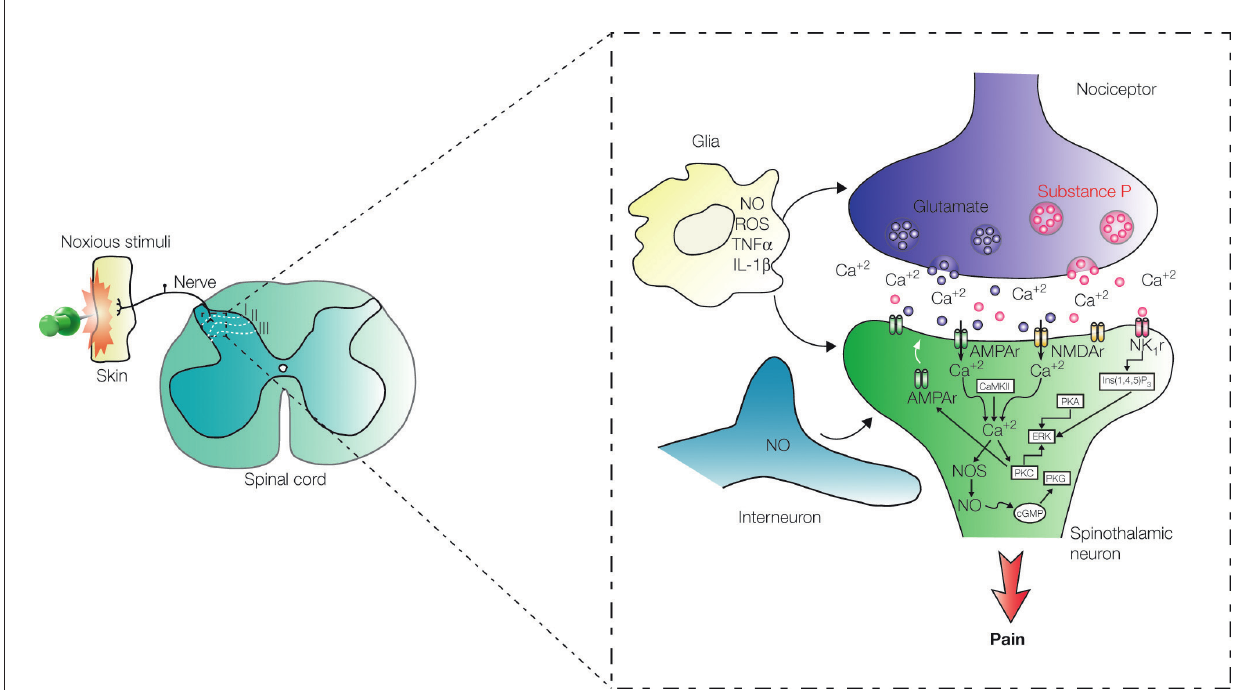
Figure 2 | Processing of pain information in the spinal cord. Pain signals are transmitted to the dorsal horn by nociceptive terminals that synapse with neurons located in laminae I, II, and III. Early-onset activity-dependent central sensitization of ascending pathways depends on LTP of the synapse between peripheral terminal containing substance P and spinothalamic projection neurons in lamina I. Pain sensitization depends, in some level, on nitric oxide (NO) released by interneurons located in laminae II and III and also by glial